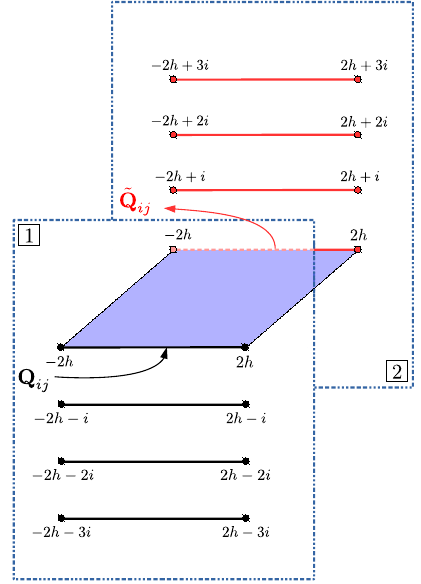
JHEP09(2017)140